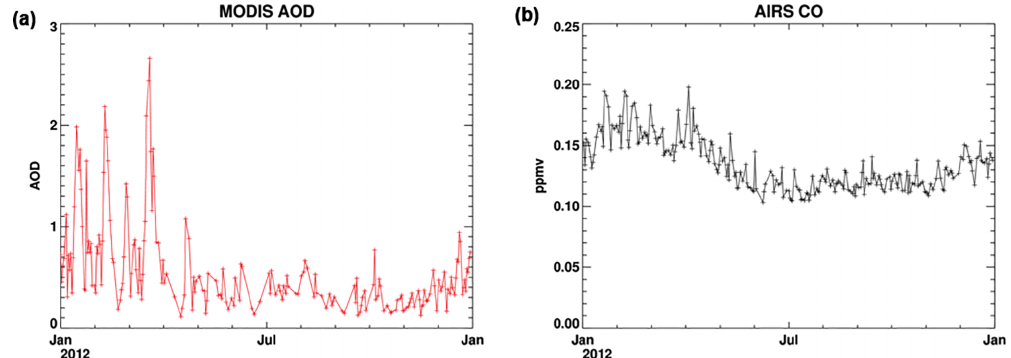
Figure A3. 2012 time series over the Lagos area: MODIS AOD (a) and AIRS CO (b)